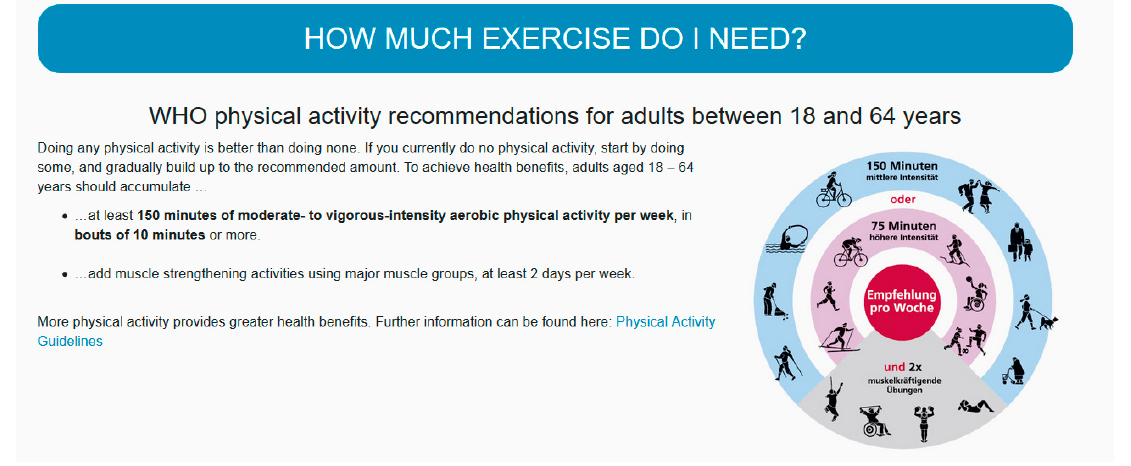
Figure 2. World Health Organization (2010) physical activity recommendations. Figure by Fonds Gesundes Österreich (2018).